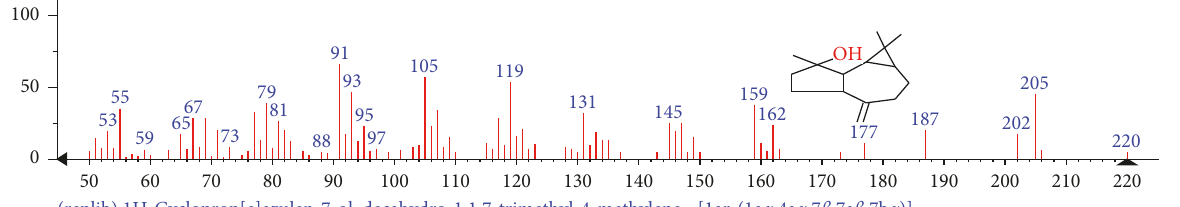
)]-50 60 (replib) 1H-Cycloprop[e]azulen-7-ol, decahydro-1,1,7-trimethyl-4-methylene-, [1ar-(1a α ,4a α ,7 β ,7a β ,7b α Figure 23: Mass spectrum of compound 1H-cycloprop[e]azulen-7-ol, decahydro-1,1,7-trimethyl-4-methylene-, [1ar- (1a α ,4a α ,7 β ,7a β ,7b α )]- of whole plant hexane fraction of Achillea wilhelmsii (WHFAW).